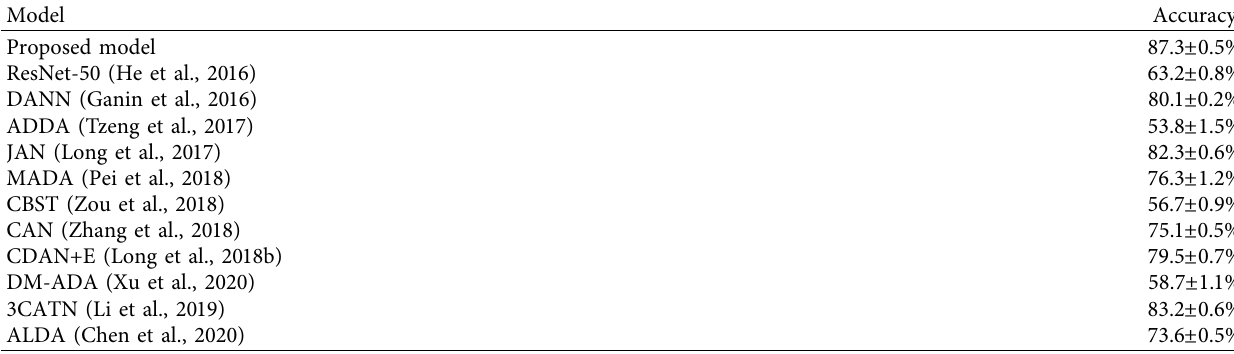
Table 3: Accuracy of diagnosis under different transfer learning approaches.